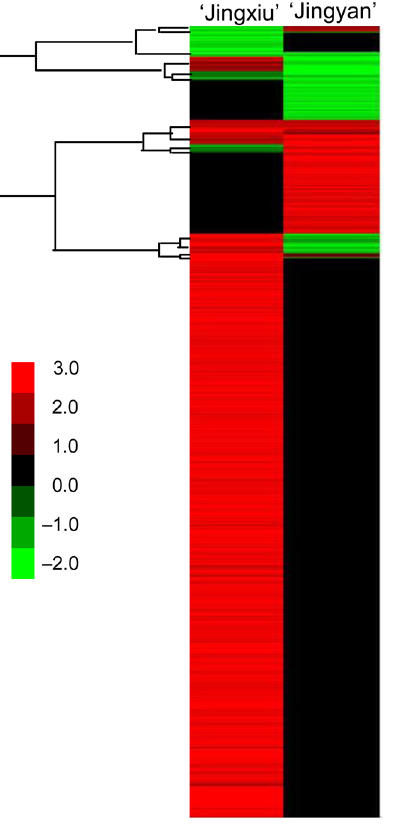
Figure 2. Standard average linkage (Euclidean distance) hierarchical clustering analysis of the differentially regulated genes that showed at least a twofold change ( P , 0.0001) between sunlight-excluded and sunlight-exposed berry skins of ‘Jingxiu’ and ‘Jingyan’ grapes. Different colors represent down- (–) and up- ( + ) regulated genes.